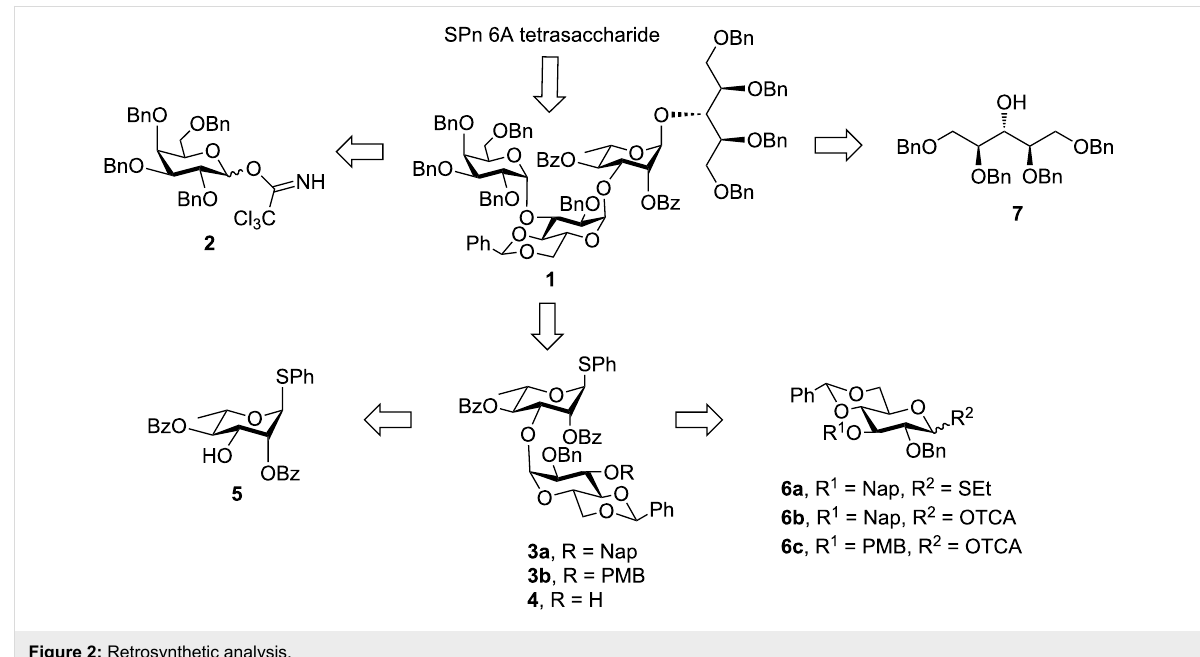
Figure 2: Retrosynthetic